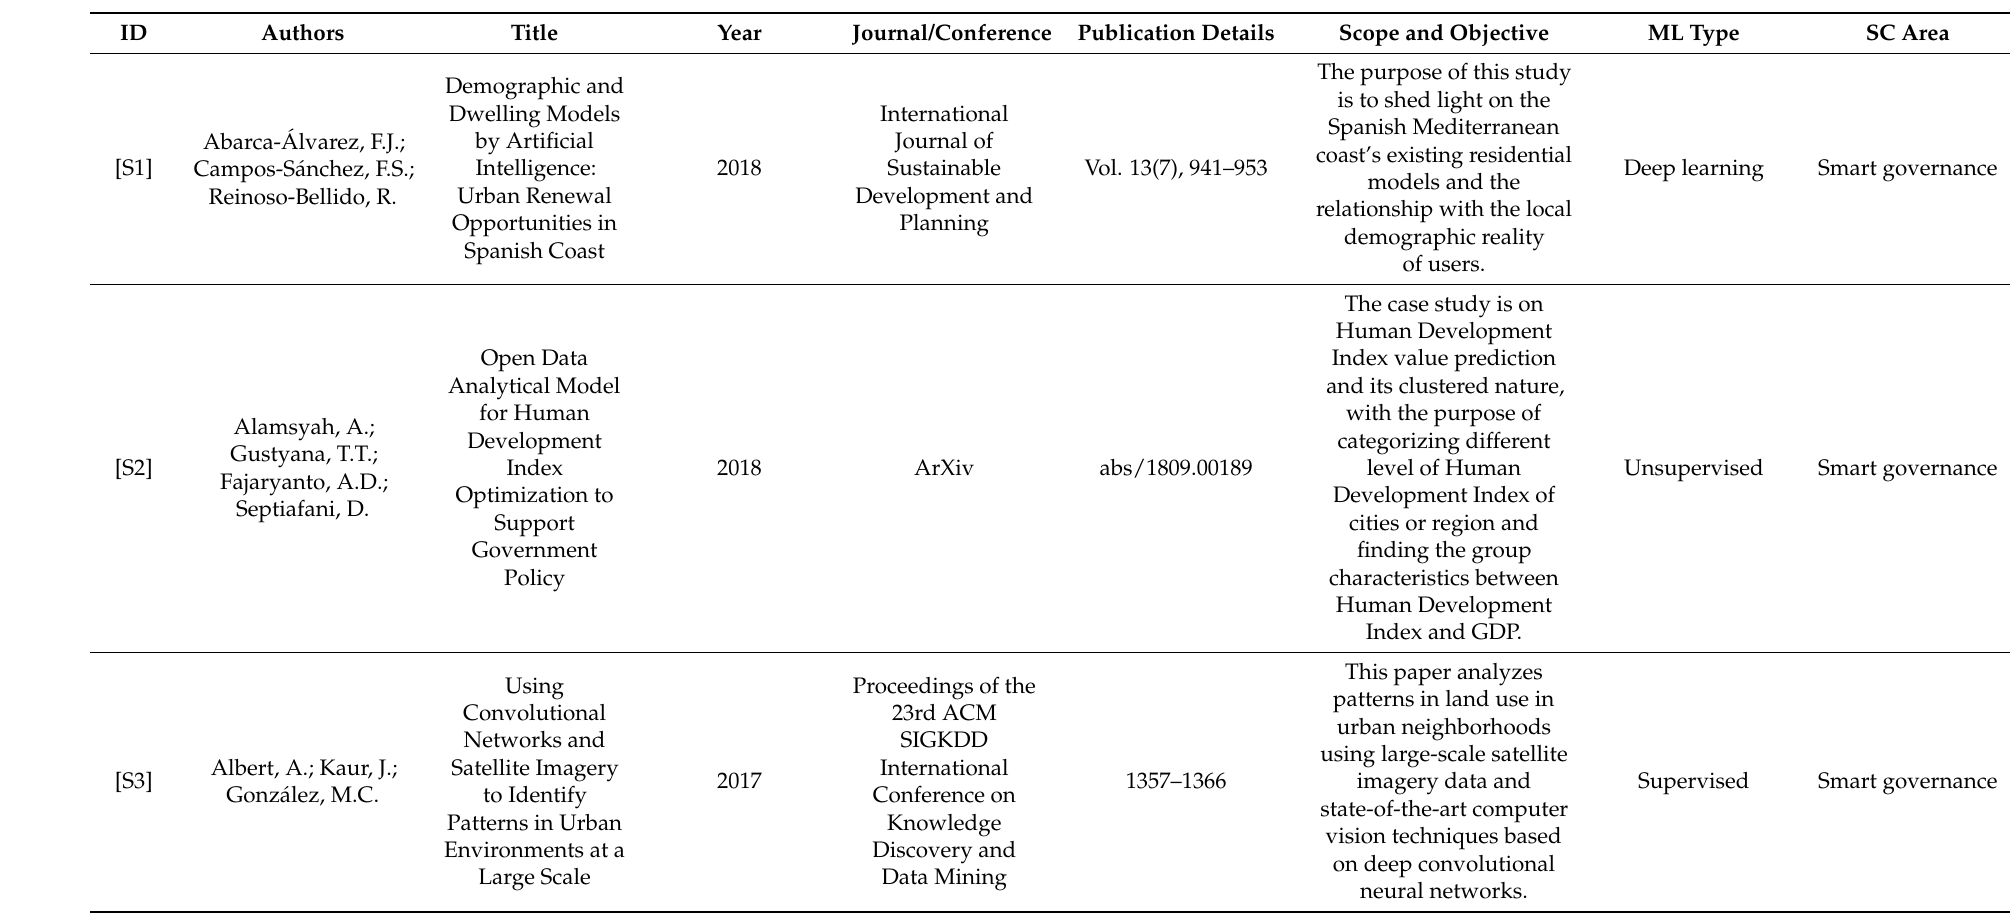
Table A1. The sample of selected